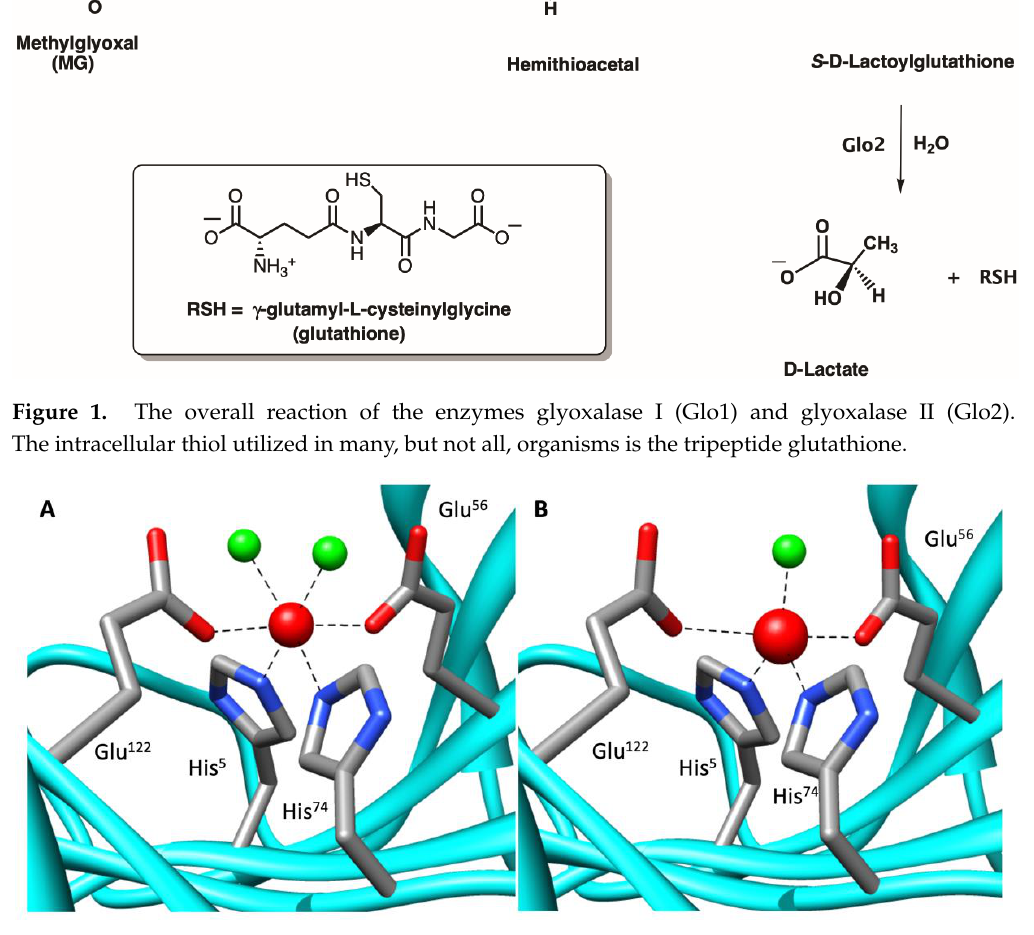
Figure 2. The ribbon structure of ( A ) the active Ni 2 + -bound Escherichia coli Glo1 (PDB ID: 1F9Z) forming an octahedral geometry with four metal-binding residues (His 5 , Glu 56 , His 74 and Glu 122 ) and two nearby water molecules around the metal center and ( B ) the inactive Zn 2 + -bound E. coli Glo1 (PDB ID: 1FA5) forming a trigonal bipyramidal metal coordination with the same four metal-binding residues but with only one water molecule [27]. The metal-binding residues are shown in sticks, and active site water molecules are shown in green. The divalent metals in the catalytic pocket are represented as red spheres. The 3D structures were generated by using the UCSF Chimera program (University of California, San Francisco, CA, USA) [33].